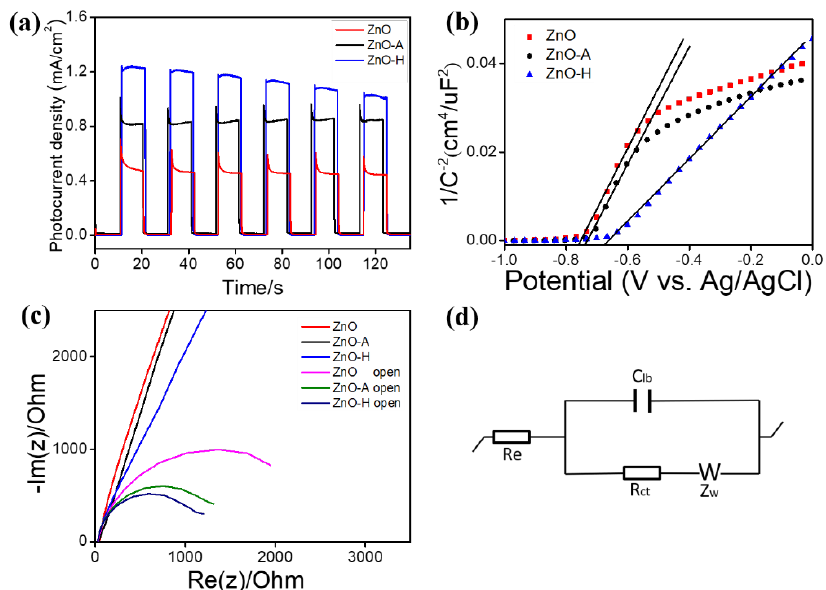
Figure 7. ( a ) Photocurrent density versus time curves of various ZnO sheets with chopped light irradiation. ( b ) Mott–Schottky plots. ( c ) Nyquist plots. ( d ) A possible equivalent circuit used to evaluate Rct value of various ZnO sheets.